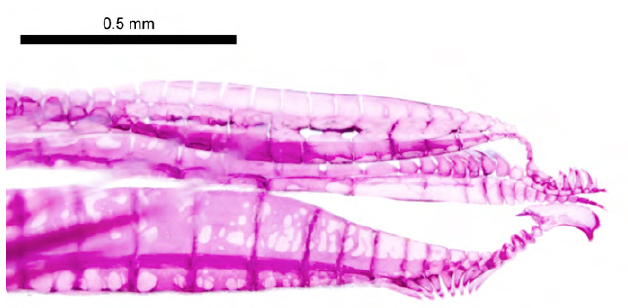
Figure 4 . Distal tip of gonopodium in Xiphophorus maculatus (CZUT-IC-